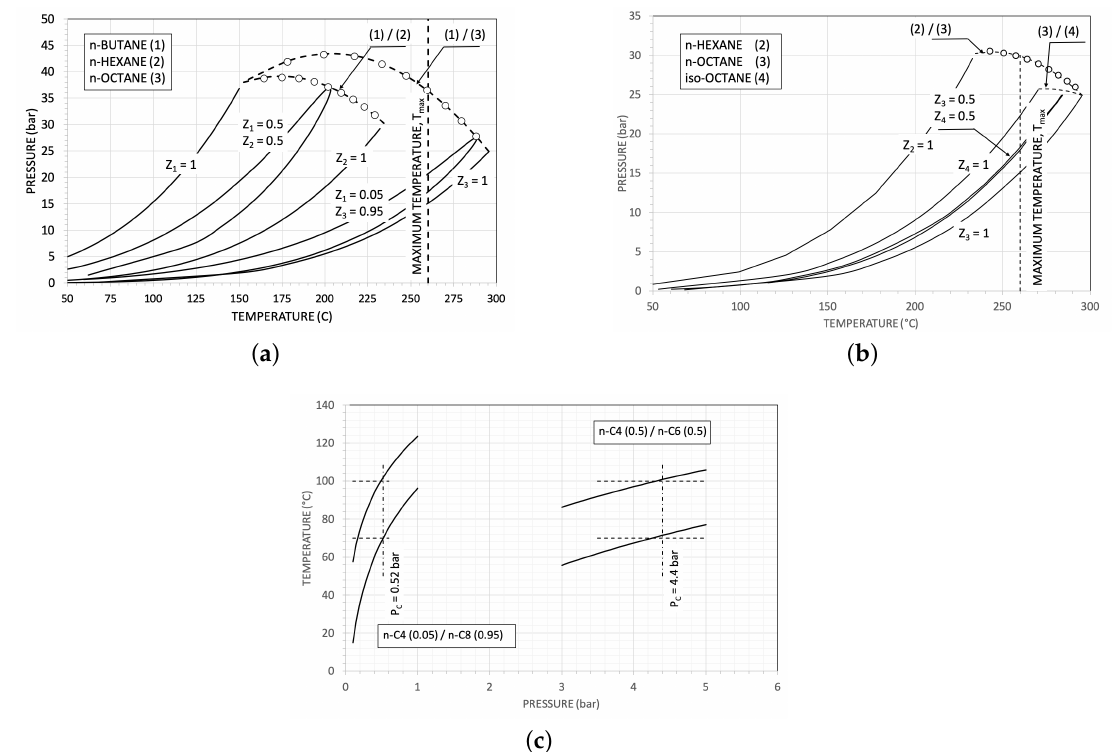
Figure 5. Critical loci for some mixtures (dotted lines). The white circle are from experimental literature data [35]. ( a ) Critical loci and some P − T envelops for mixtures of n-C4/n-C6 and n-C4/n-C8. ( b ) Critical loci and P − T envelops for mixtures of n-C6/n-C8 and n-C8/i-C8. ( c ) P − T envelops for two mixtures around a dew temperature of 100 ◦